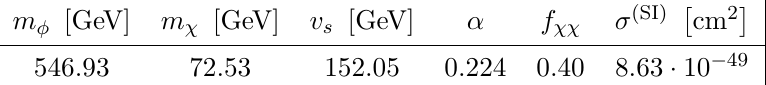
Table 1 . Benchmark point of the PNGDM: The benchmark point is used to illustrate the param- eter dependencies in the following. This parameter point provides an SI cross section above the neutrino